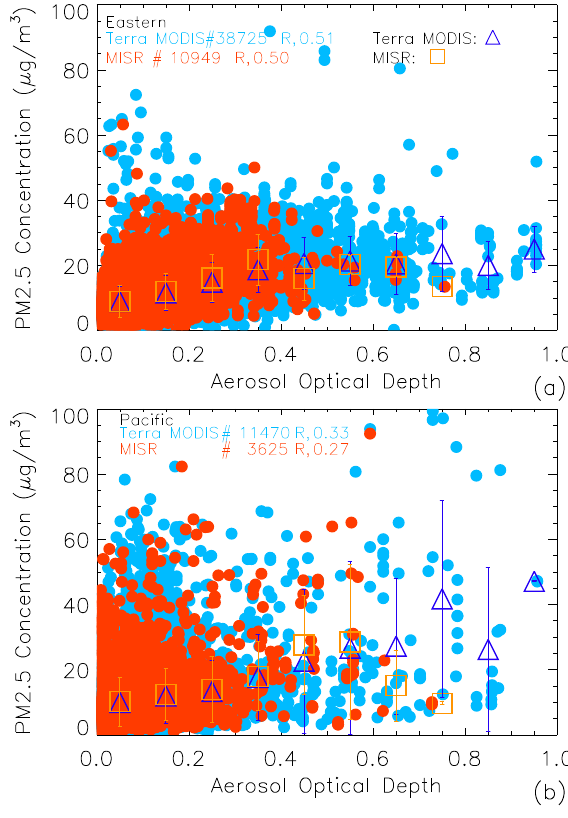
Figure 3. Two-year (2008–2009) scatterplots of daily 1 ◦ × 1 ◦ DA Terra MODIS (in light blue) and daily 1 ◦ × 1 ◦ MISR (in red) AOD versus daily PM 2 . 5 concentrations for the (a) eastern and (b) Pacific US time zones. Averages of PM 2 . 5 are plotted for each 0.1 AOD bin, represented with triangles (in dark blue) for Terra MODIS and squares (in orange) for MISR. Error bars ( ± 1 standard deviation) for the bin averages are also